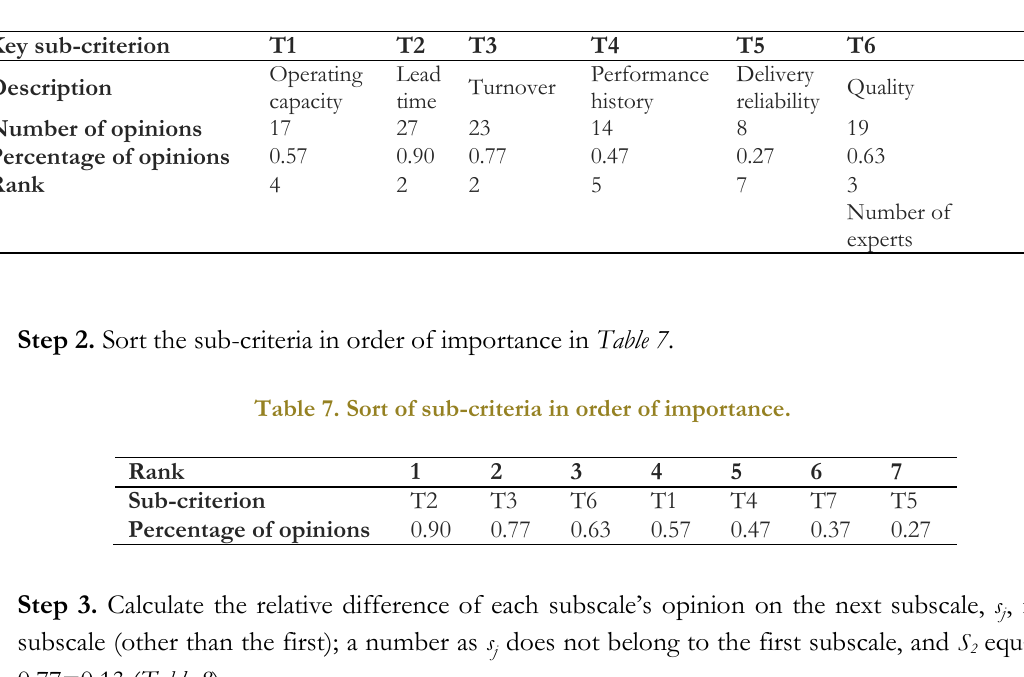
Table 8. The value of s